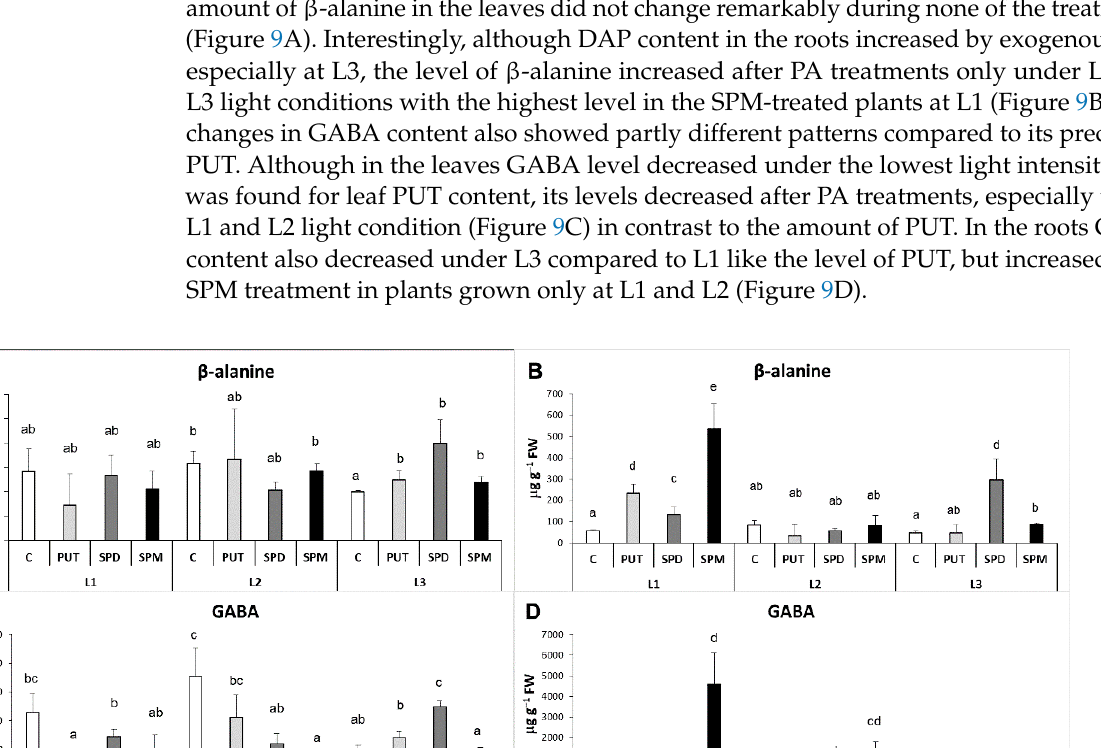
Figure 10. Effect of different light intensities on the salicylic acid (SA) ( A , C ) and abscisic acid (ABA) ( B , D ) content in the leaves ( A , B ) and roots ( C , D ) of plants grown under 16 h/8 h day/night light period with different light intensity conditions: 500 (elevated light: L1), 250 (medium light: L2) and 50 (lower light: L3) μ mol m 2 s − 1 LED light after 7 days of 0.3 mM